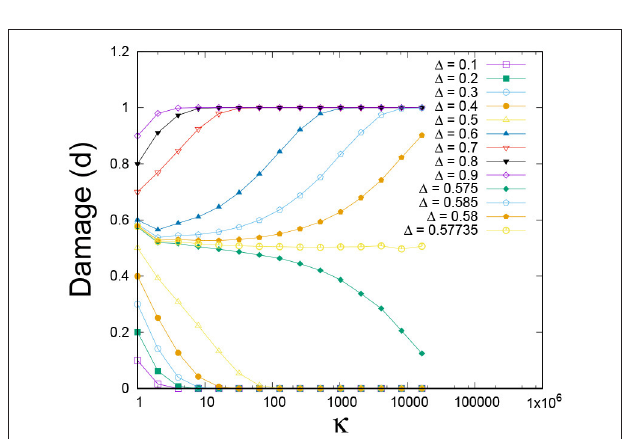
FIGURE 9 | Evolution of the peak-stress and peak-strain under the real space renormalization group. The starting point was 10 6 fiber bundles each containing N 2 15 fibers. The threshold distribution was uniform on the unit = interval.